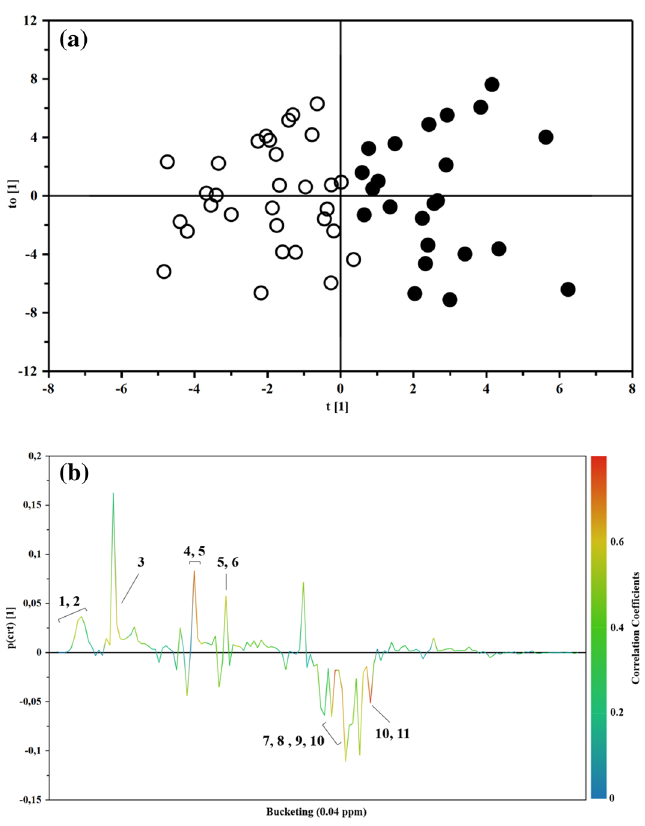
Figure 1. ( a ) OPLS-DA scores plot of 1 H-NMR spectra of plasma samples: Controls (full circle), IEI-EMF subjects (open circle). ( b ) Color-coded coefficient loadings plot of metabolomics profile between Controls and IEI-EMF subjects. Peaks: 1 and 2 , 2-hydroxyisocaproate and Isoleucine; 3 , Lactate; 4 and 5 , Homoserine and Glutamine; 5 and 6 , Glutamine and Pyroglutamate; 7, 8, 9 and 10 , Glutamine, Glycine, Myo-inositol and Choline; 10 and 11 , Serine and Choline.